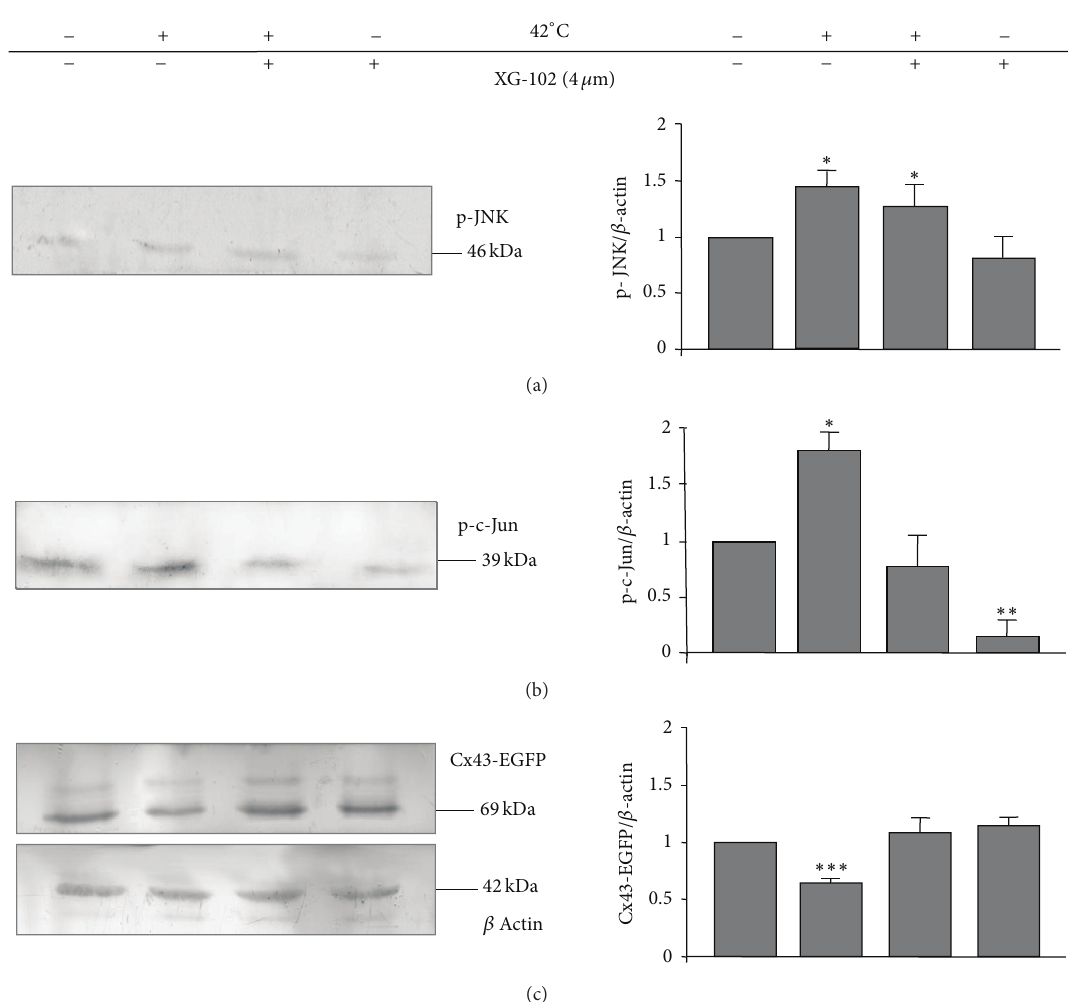
Figure 7: Effect of hyperthermia on the total expression of p-JNK (a), p-c-Jun (b), and Cx43-EGFP proteins (c) in HeLa cells. 𝑛 = 3 in each set of experiments; ∗ = 𝑃 < 0.05 ; ∗∗ = 𝑃 < 0.01 ; ∗∗∗ = 𝑃 < 0.005 , Student’s 𝑡